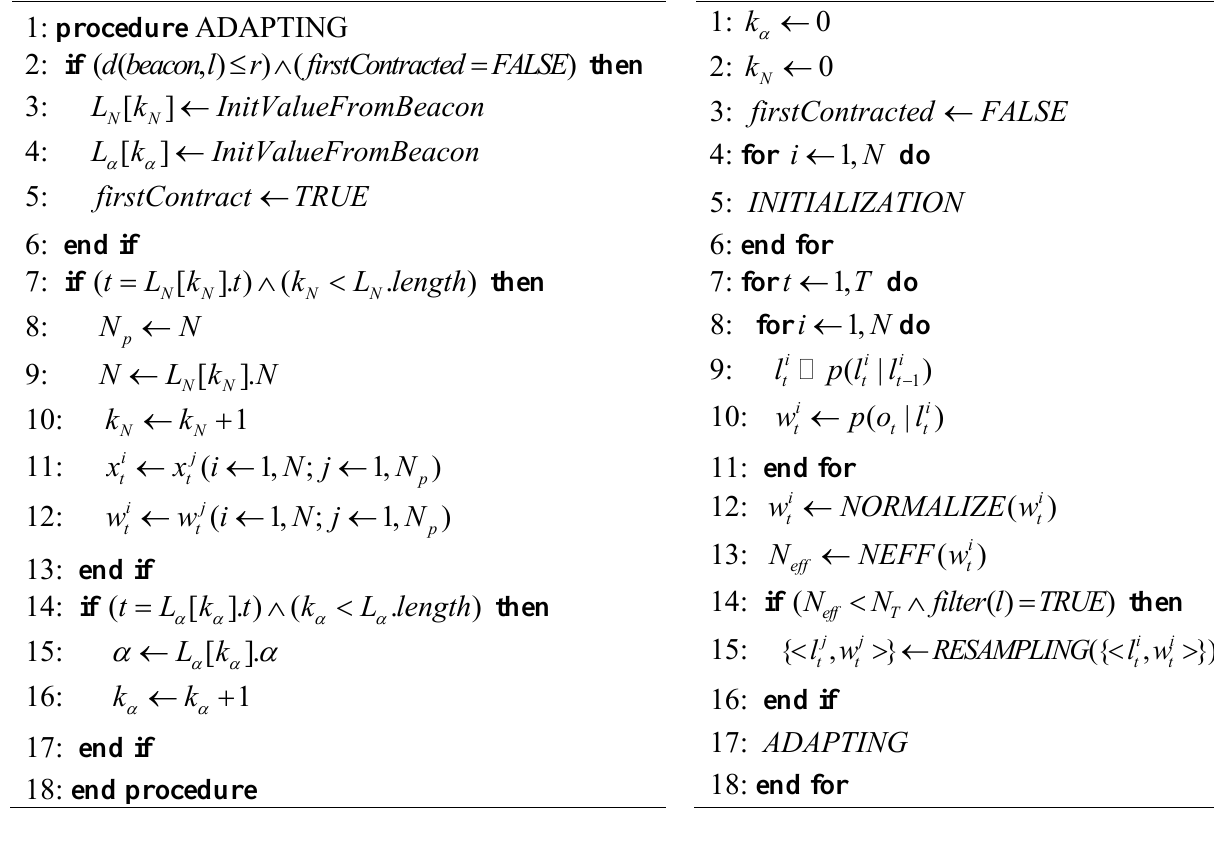
Algorithm 2. adaptive step in unknown node. Algorithm 3.